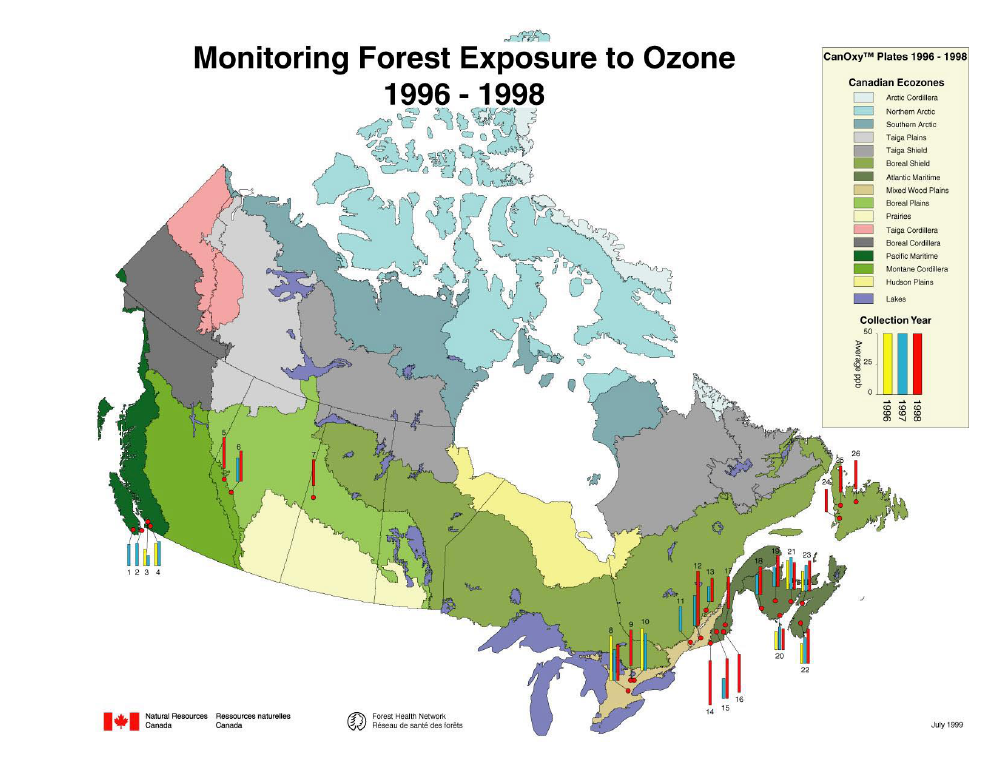
FIGURE 2. Locations in the national network of forest health monitoring plots of the Canadian Forest Service–Forest Health Network used in the ozone passive sampling, showing the spatial and temporal variation in canopy ozone exposure over three